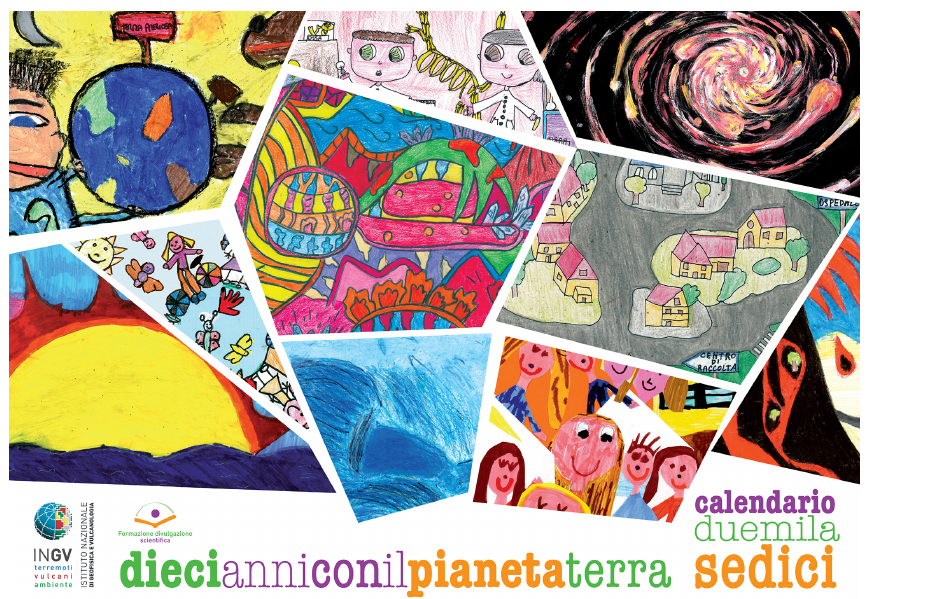
Figure 1. The cover page of the 2016 calendar made with a collage of all previous calendar covers (edited by INGV Laboratorio Didattica e Divulgazione Scientifica and INGV Laboratorio Grafica e